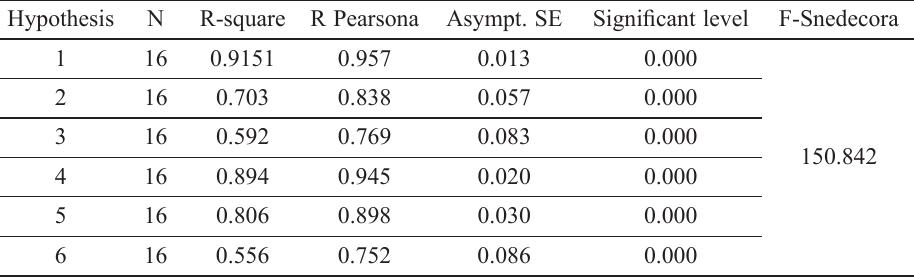
Table 6. Results of the tests used in testing hypothesis